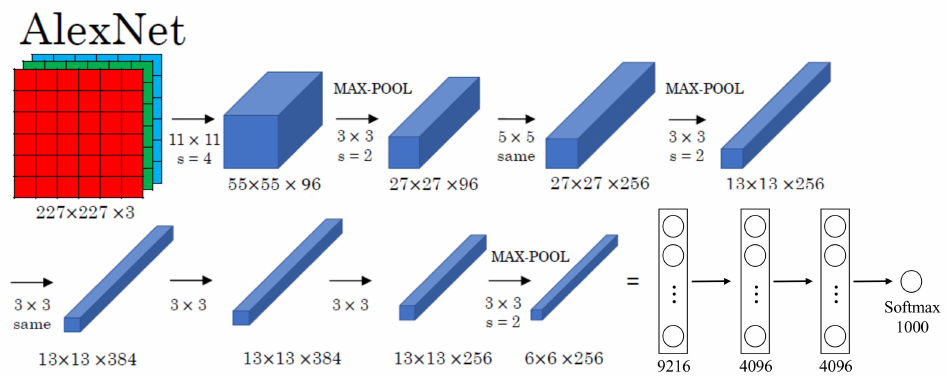
Figure 4. Overall framework for the improved network.